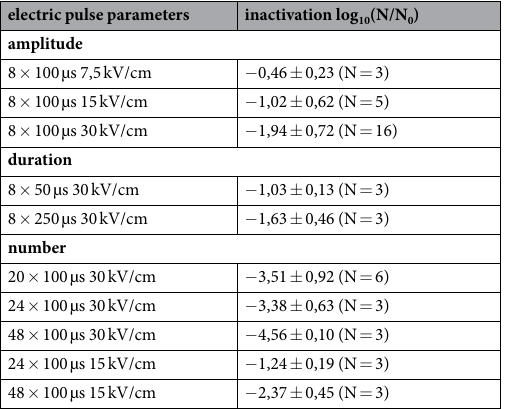
Table 1. Preliminary experiments for determination of electric pulse parameters for flow through electroporation system. Experiments were performed in stationary electroporation chamber with aluminium